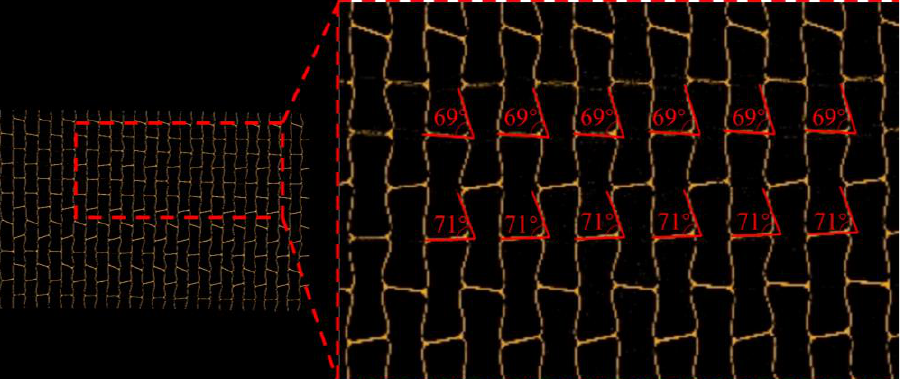
Figure 7. The angles of the deformed honeycomb on the nonplanar expansion of the honeycomb core tube.